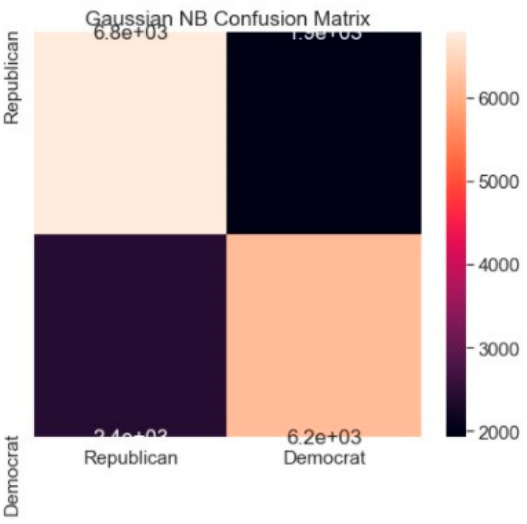
Figure 15. Confusion Matrix for Gaussian NB.